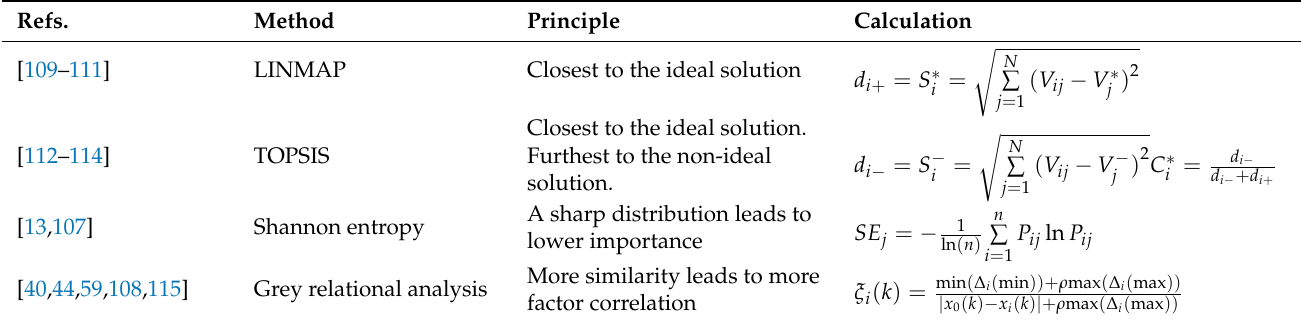
Figure 9 . Statistical results of MCDM applied in ORC. Figure 9. Statistical results of MCDM applied in ORC. Table 4. Descriptions of different MCDM methods Table 4. Descriptions of different MCDM